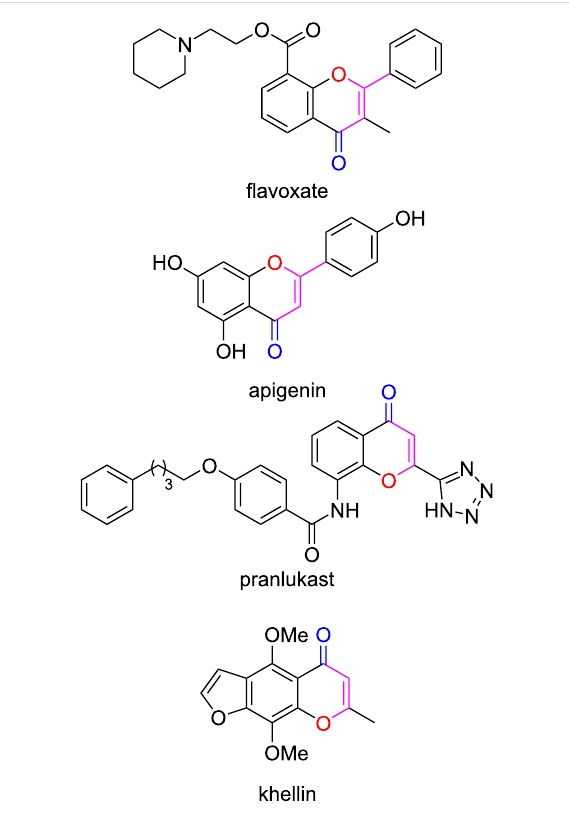
Figure 1: Biologically active chromone